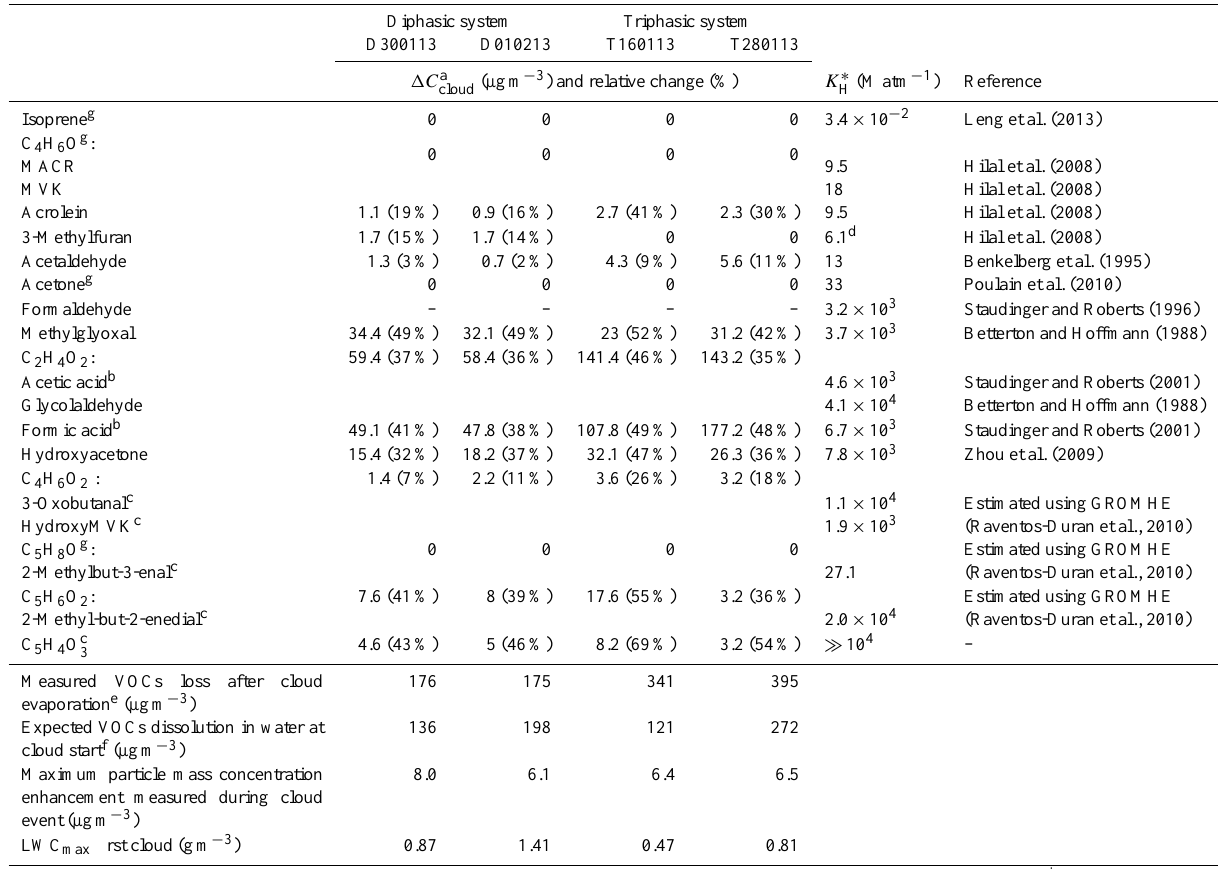
Table 4. Comparison between measured VOC loss, potential aqueous phase dissolution of gas phase species and particle formation during cloud events of each system.